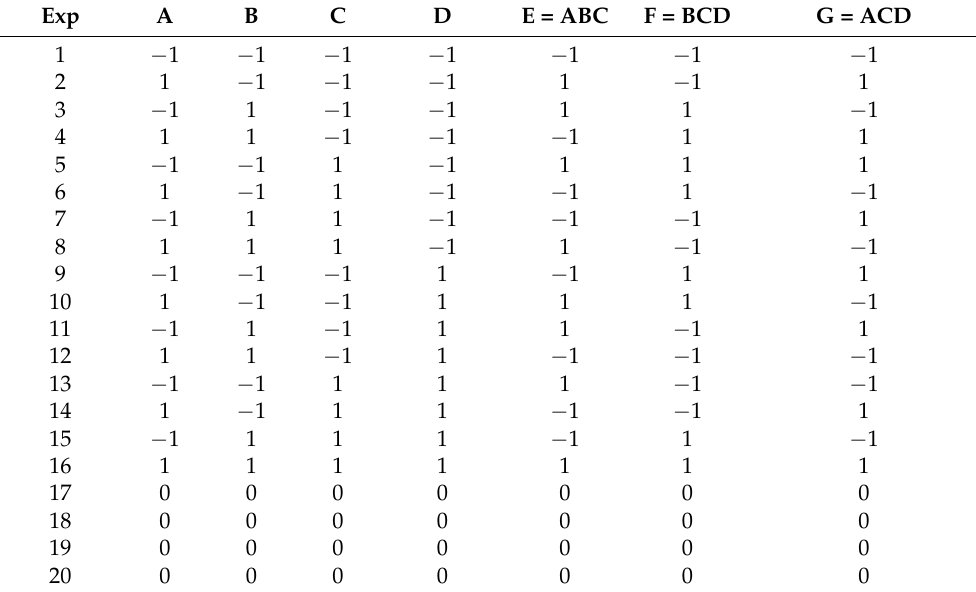
Table 7. 2 7 − 3 fractional factorial design of the